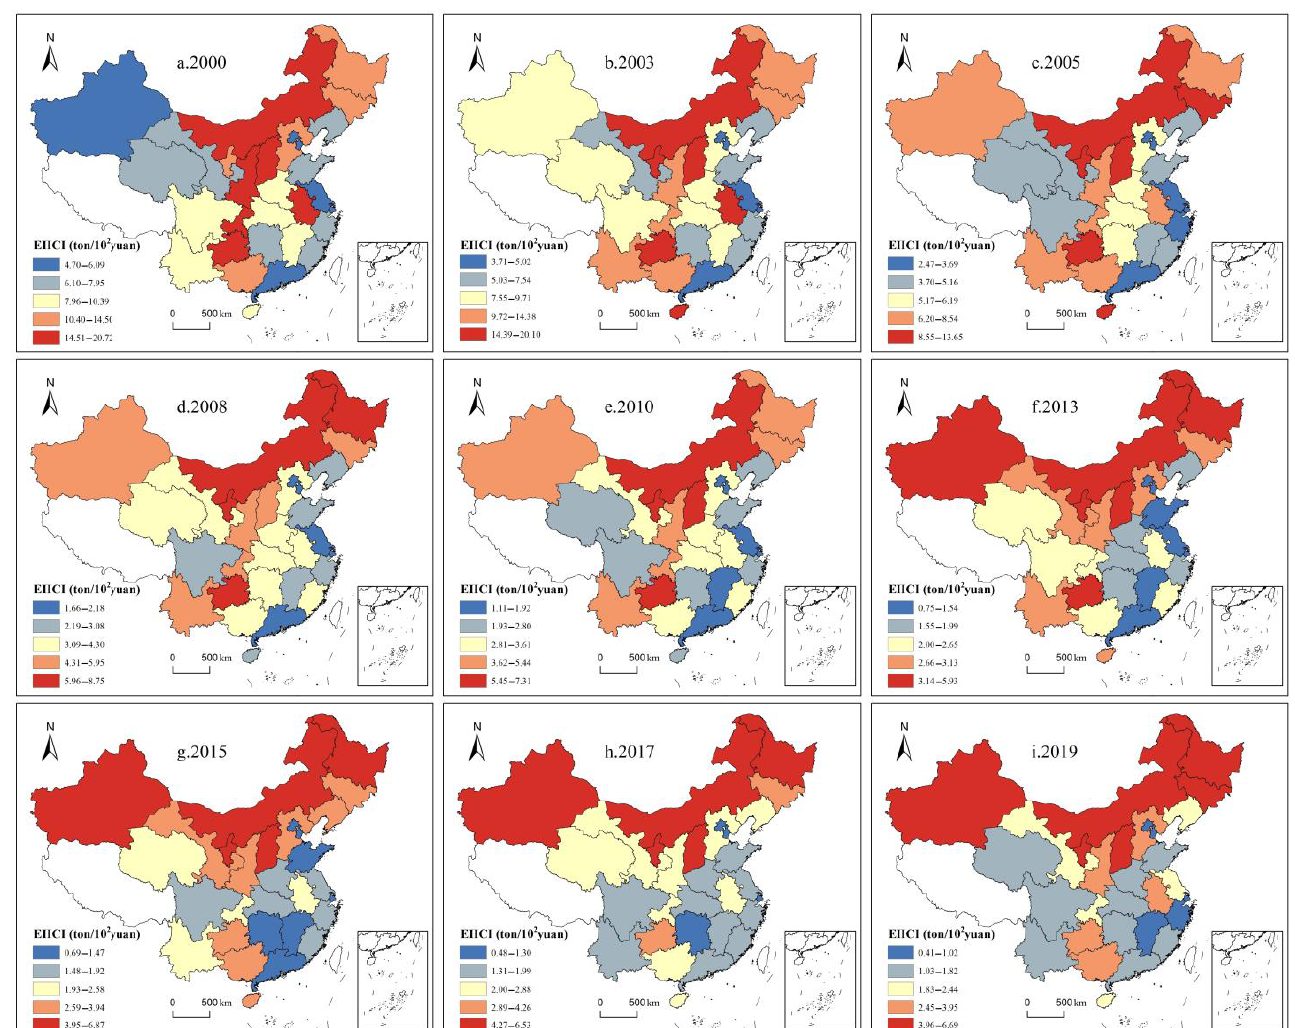
Figure 2. Spatiotemporal differences of China’s EIICI from 2000 to 2019. Table 2. Distribution of the three major regions in